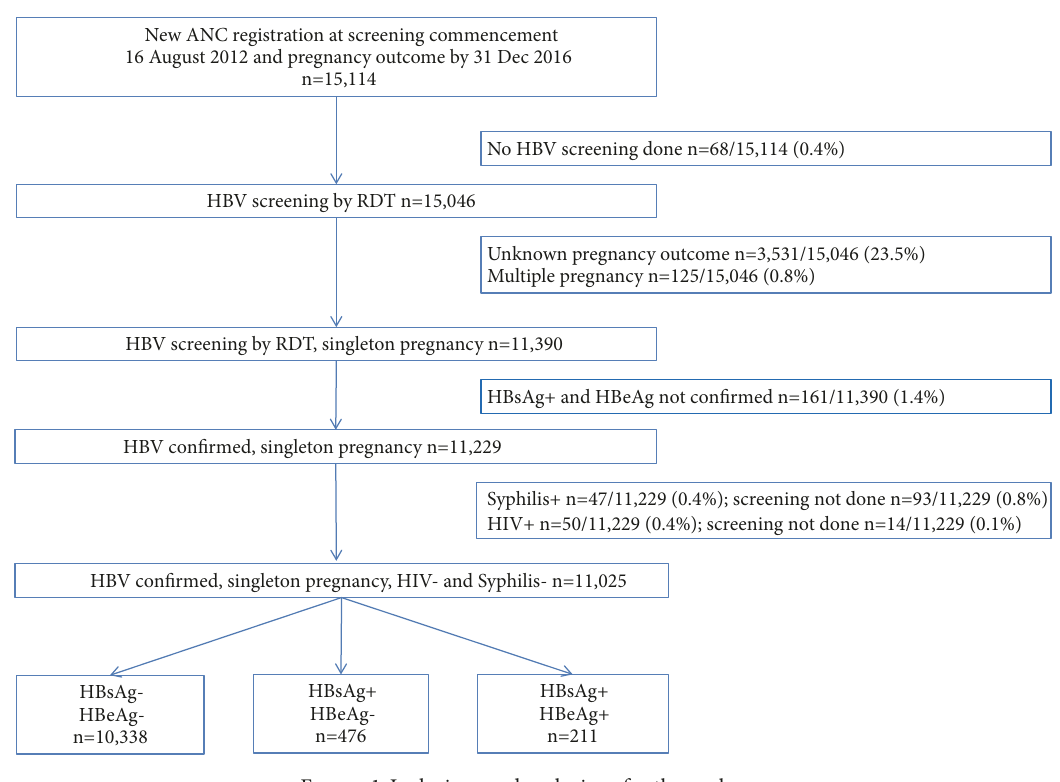
Figure 1: Inclusions and exclusions for the